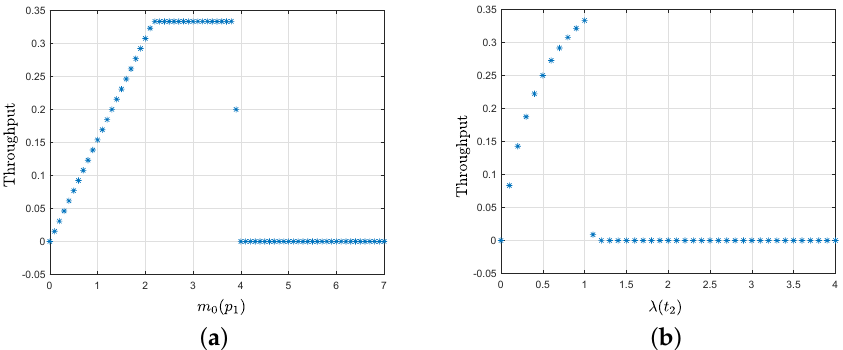
Figure 2. Equilibrium throughput of the Petri net model with respect to the initial marking and with respect to the firing rates. ( a ) Initial marking variation k 1 . ( b ) Firing rate variation λ 2